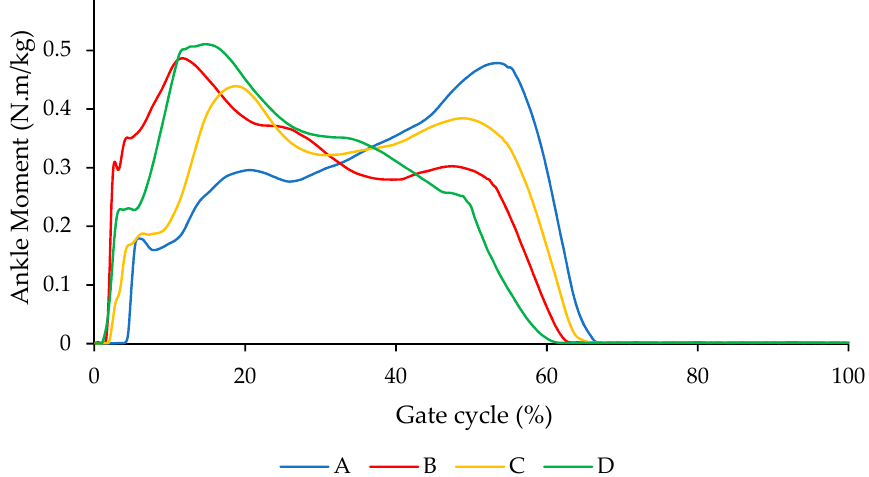
Figure 13. Comparison of the ankle moment for different conditions including (A) subject with bare foot, (B) subject wearing conventional HAFO with no spring, (C) subject wearing conventional Stainless Steel-based HAFO, and (D) subject wearing NiTi spring based HAFO. (Case I).